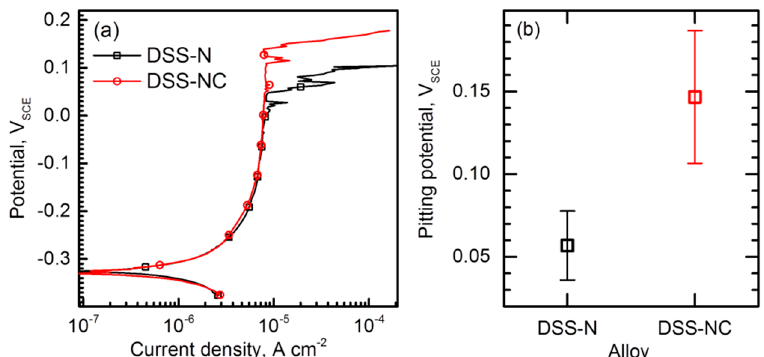
Figure 6. Resistance to pitting corrosion of the DSSs: ( a ) Linear potentiodynamic polarization curves of the DSSs measured in a 5 M NaCl solution at 50 ◦ C with a potential sweep rate of 2 mV s − 1 and ( b ) the average and standard deviation values (scatter band) of the pitting potentials obtained from 5 repeated polarization tests. Table 3. The corrosion characteristics of the DSS-N and DSS-NC measured through polarization tests